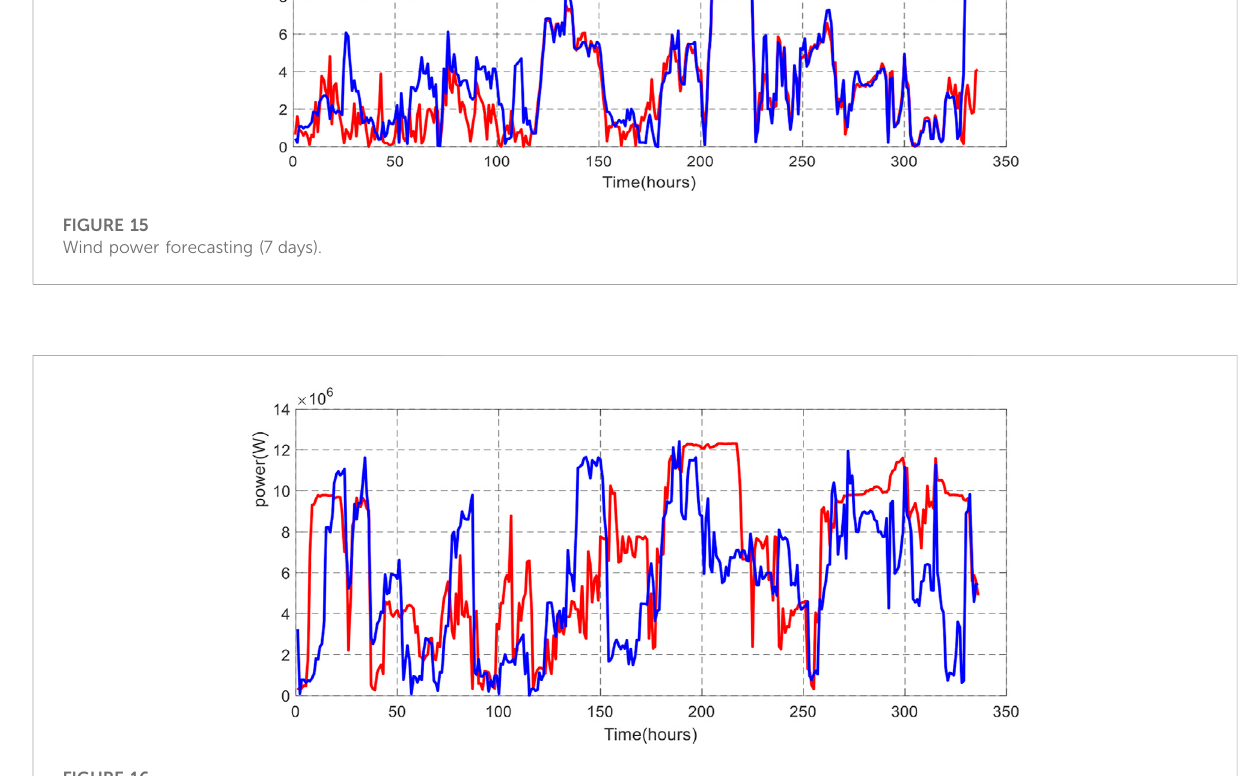
FIGURE 16 Load demand prediction (7